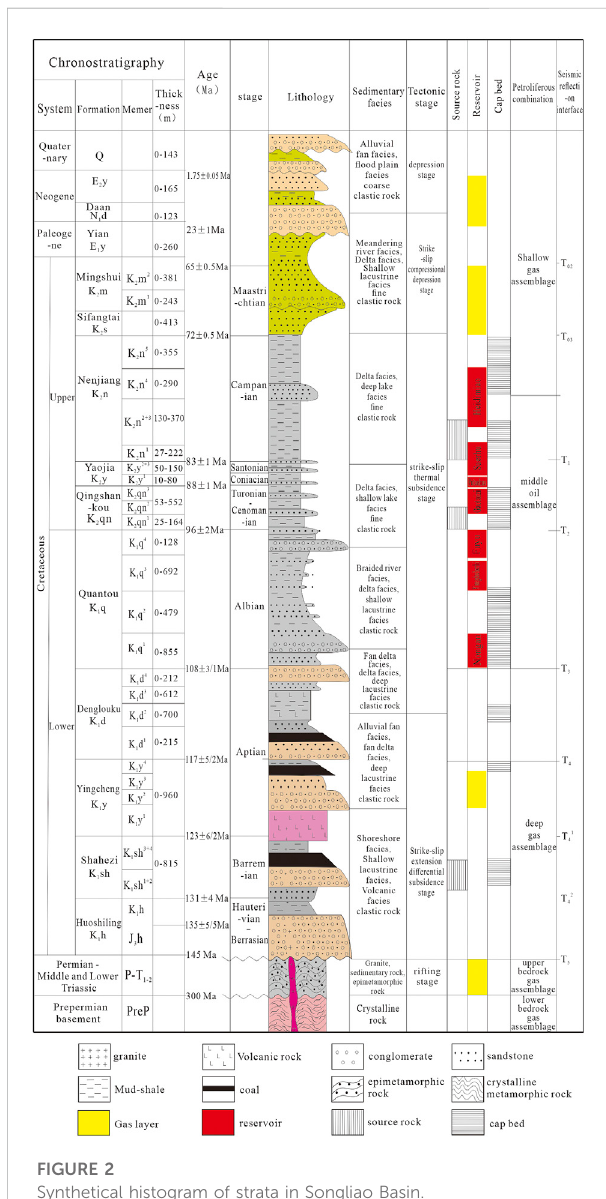
FIGURE 2 Synthetical histogram of strata in Songliao